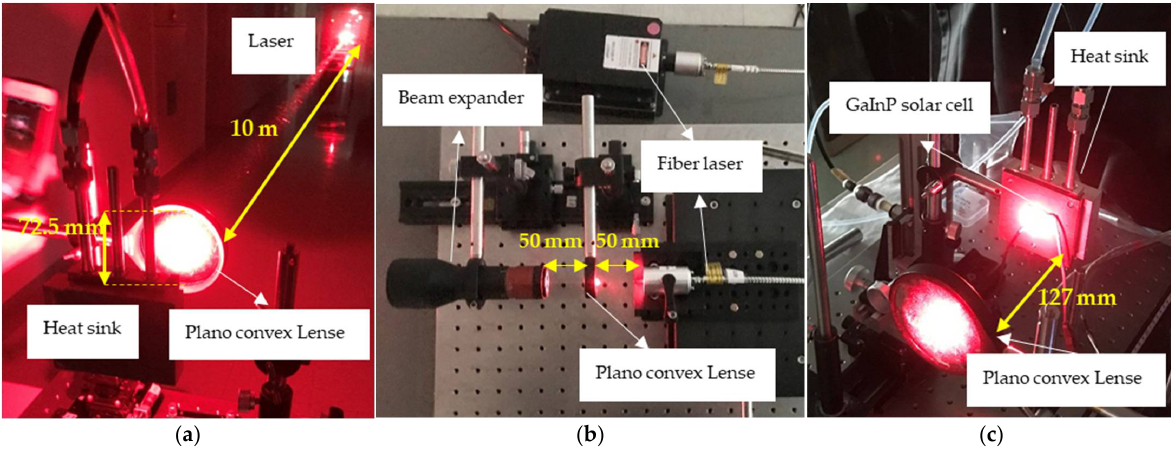
Figure 2. Experiment setup ( a ), Light source side view ( b ), and Solar cell side view ( c ).